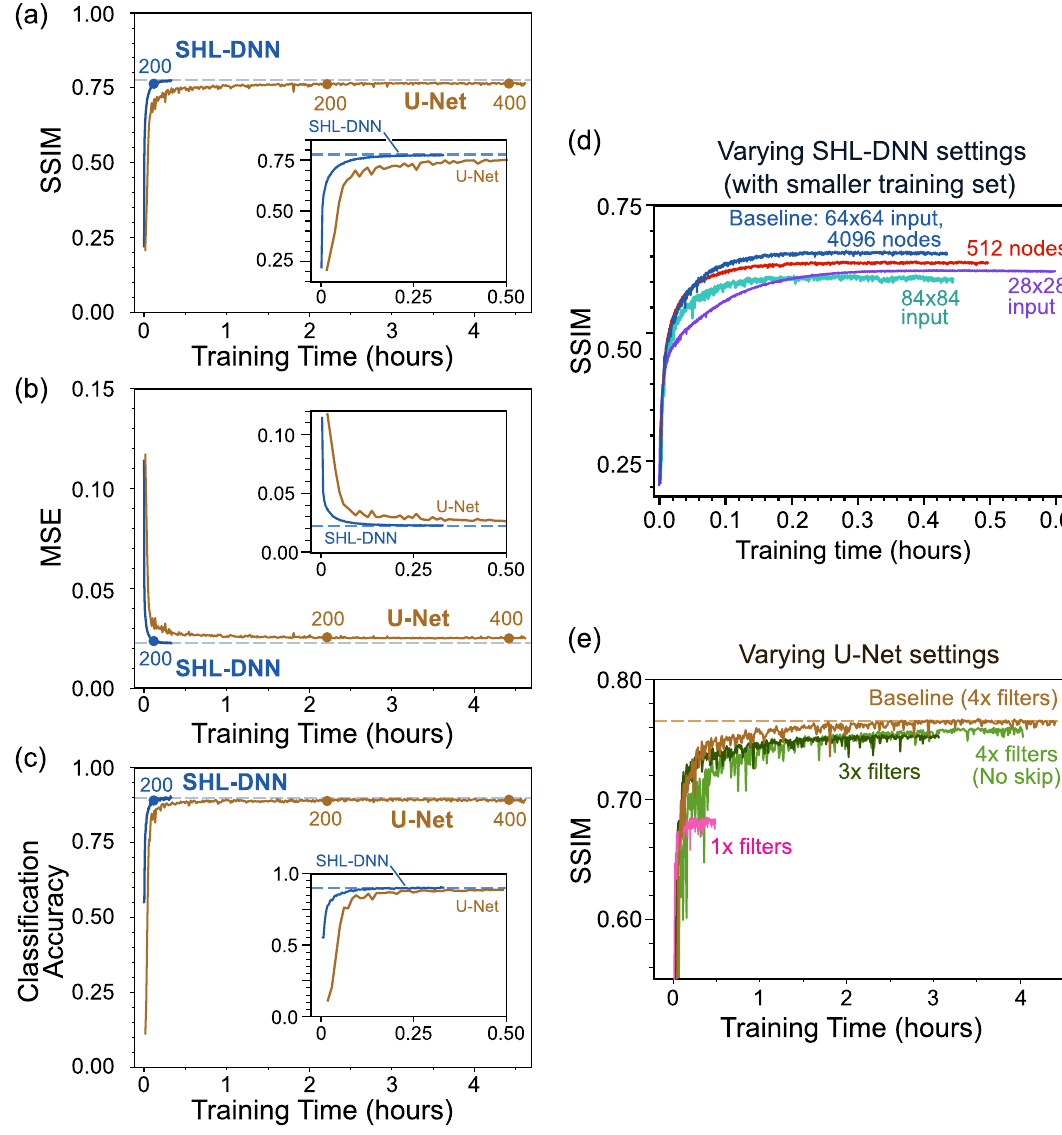
Figure 3. ( a )–( c ) Training curves for SHL-DNN and U-Net, using SSIM as the objective function and with 27685 training images and 3077 validation images. Epoch numbers are indicated by the numbered circles on each curve. ( a ) SSIM versus training time. ( b ) Mean squared error (MSE) versus training time. ( c ) Classification accuracy versus training time, obtained by feeding the output images from each neural network into an auxiliary classifier network, serving as a measure of legibility. In ( a )–( c ), the converged performance measure for the SHL-DNN is indicated by horizontal dashes. ( d ) SHL-DNN performance with different settings, calculated with a training set of 8709 images: the baseline network used in ( a )–( c ) and depicted in Fig. 1c, with 64 × 64 inputs and 4096 hidden layer nodes (blue), a network with 28 × 28 inputs (purple), a network with 84 × 84 inputs (green), and a network with 512 hidden layer nodes and 64 × 64 inputs (red). ( e ) U-Net performance for different settings: the baseline U-Net with “ 4 × ” filters [used in ( a )–( c ) and depicted in Fig. 1d] (brown), removed skipping layers (light green), “ 3 × ” filters (dark green), and “ 1 × ” filters (pink). In the last case, convergence is achieved about as quickly as the SHL-DNN, but at significantly lower slight decrease in performance slightly; hence, the skip connections are included in our baseline configuration (although the reason these connections are advantageous for the present task is somewhat unclear). Some of these comparisons are shown in Fig. 3e. After these optimization studies, we arrive at the SHL-DNN and U-Net configurations shown in Fig. 1c,d. In these configurations, the SHL-DNN has 20 million trainable parameters and takes 39.9 million FLOPs per forward pass, and the U-net has 31 million trainable parameters and takes 62.8 million FLOPs per forward pass.